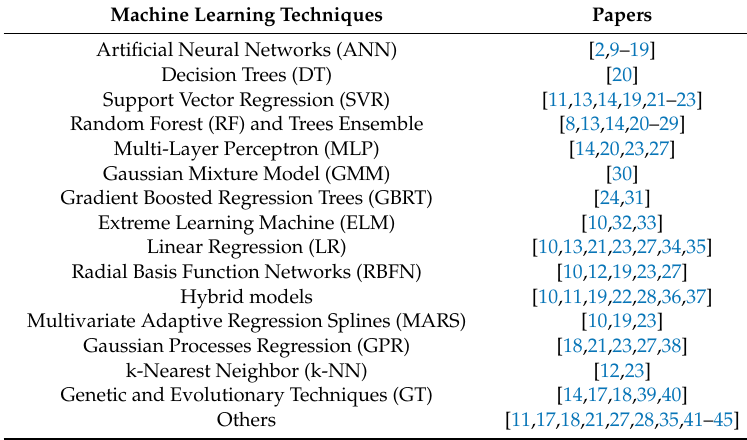
Table 1. Machine learning (ML) techniques used to model the reference [8] dataset. Machine Learning Techniques